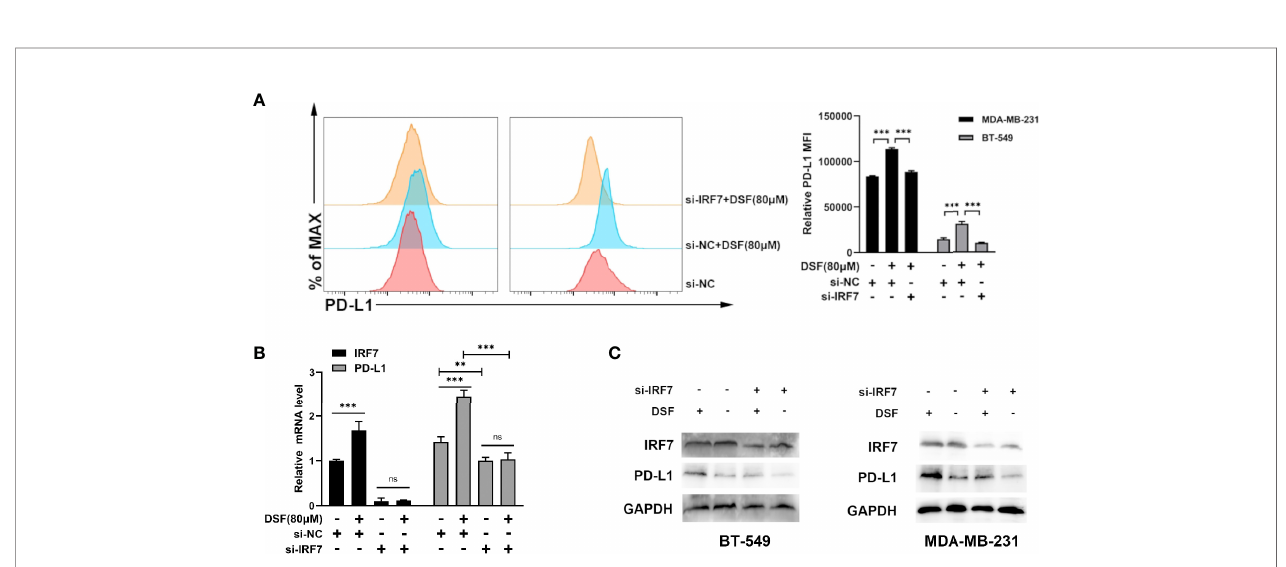
FIGURE 4 | DSF regulates PD-L1 expression through IRF7. (A) The MDA-MB-231 cell and BT-549 cell transfected with siRNA-IRF7 were treated with DSF for 48 h, and PD-L1 expression was measured by fl ow cytometry analysis. Right panel, quanti fi cation of relative MFI. (B) The mRNA expression level of IRF7 and PD-L1 in the MDA-MB-231 cell transfected with siRNA-IRF7 or siRNA-NC after the treatment of indicated concentration of DSF for 48 h. (C) The protein level of IRF7 and PD-L1 in MDA-MB-231 cell and BT-549 cell treated with siRNA-IRF7 or treated with siRNA-IRF7 or siRNA-NC were measured by western blotting after treatment with indicated doses of DSF for 48 h. **p < 0.01, ***p < 0.001. ns, no statistic signi fi cance.